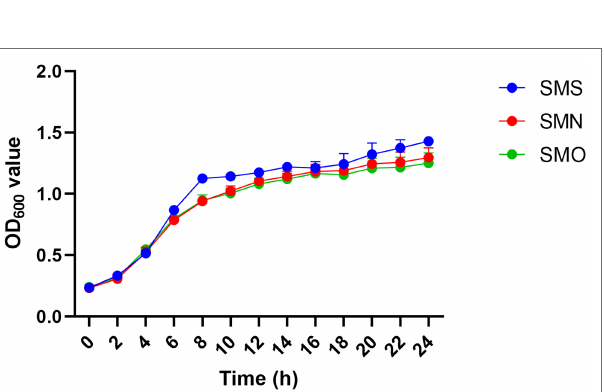
FIGURE 3 | Growth curves of three S. maltophilia samples. Growth curves of Stenotrophomonas maltophilia in simulated microgravity (SMS; blue), S. maltophilia in normal gravity (SMN; red), and original strain of S. maltophilia (SMO; green) were determined by measuring the OD 600 value.